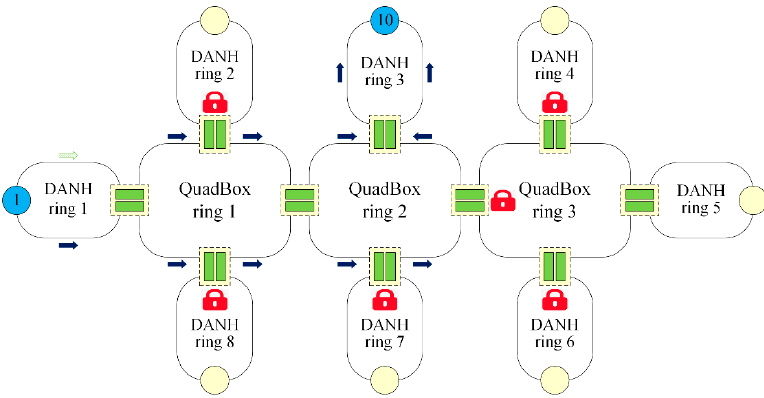
Figure 4. Forwarding a unicast frame in EFA.